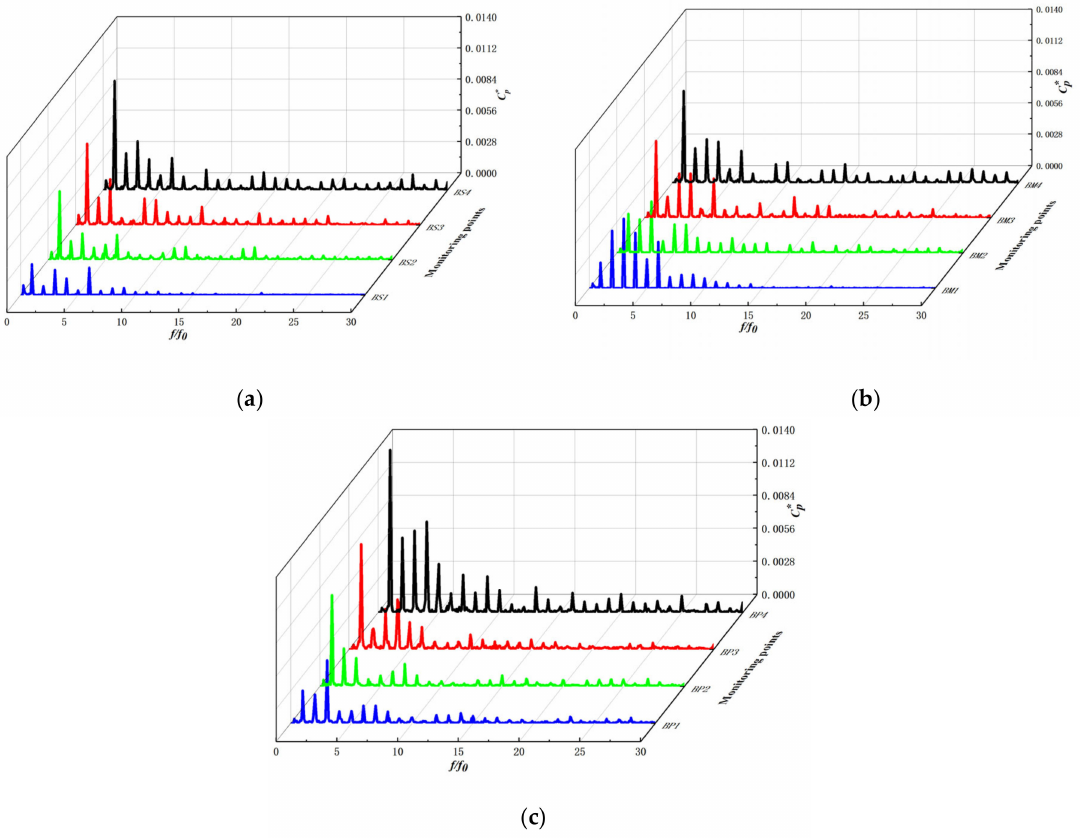
Figure 14. Frequency characteristic in the impeller. ( a ) Blade suction surface; ( b ) Middle of the flow channel; ( c ) Blade pressure